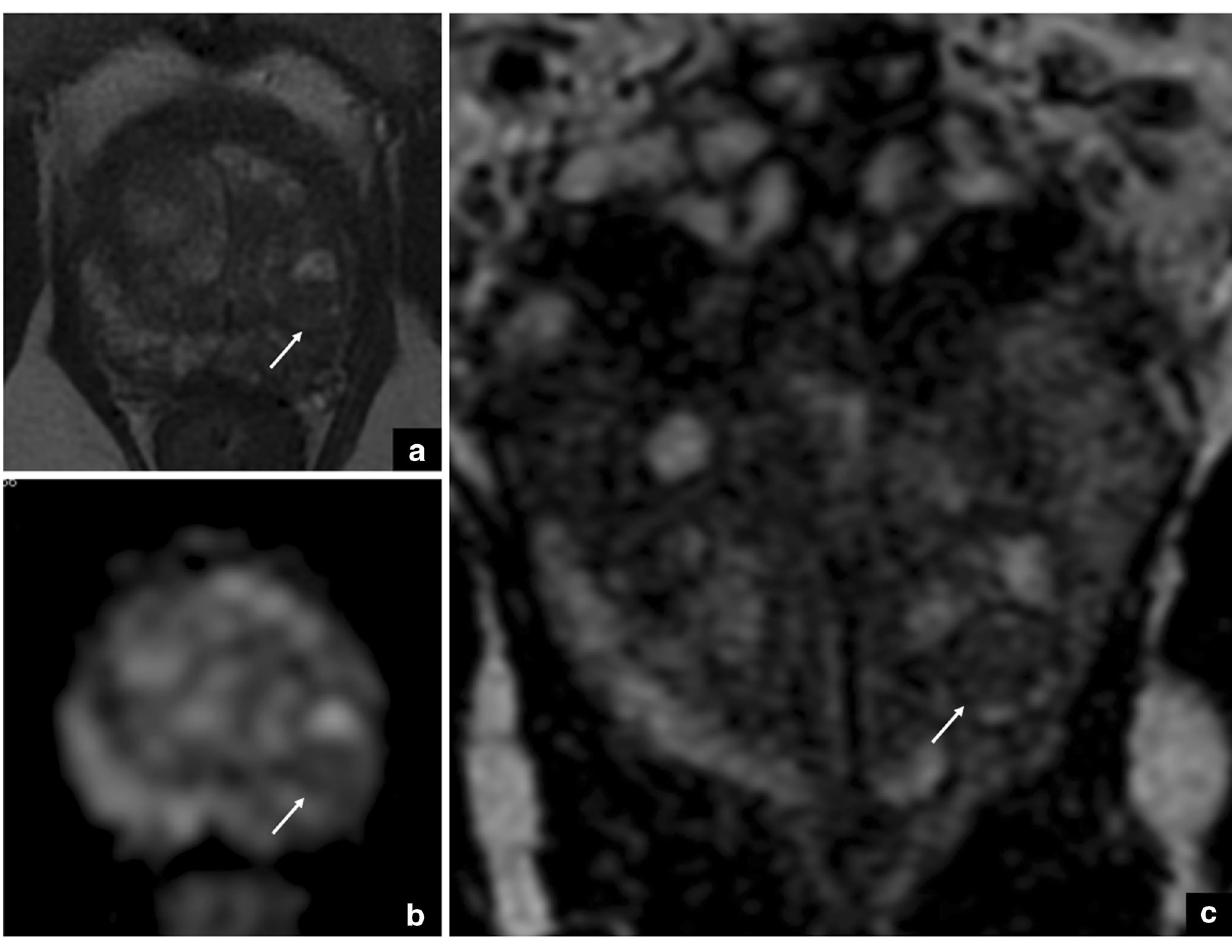
on the ADC map ( b ). The presence of tiny bright spots (corresponding to dilated acini) is consistent with a nodule of stromal benign prostatic hyperplasia (BPH), which may sometimes protrude from the central